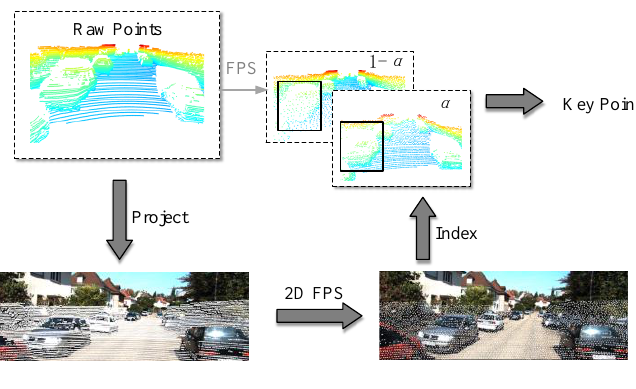
Figure 3. Illustration of the P-FPS.